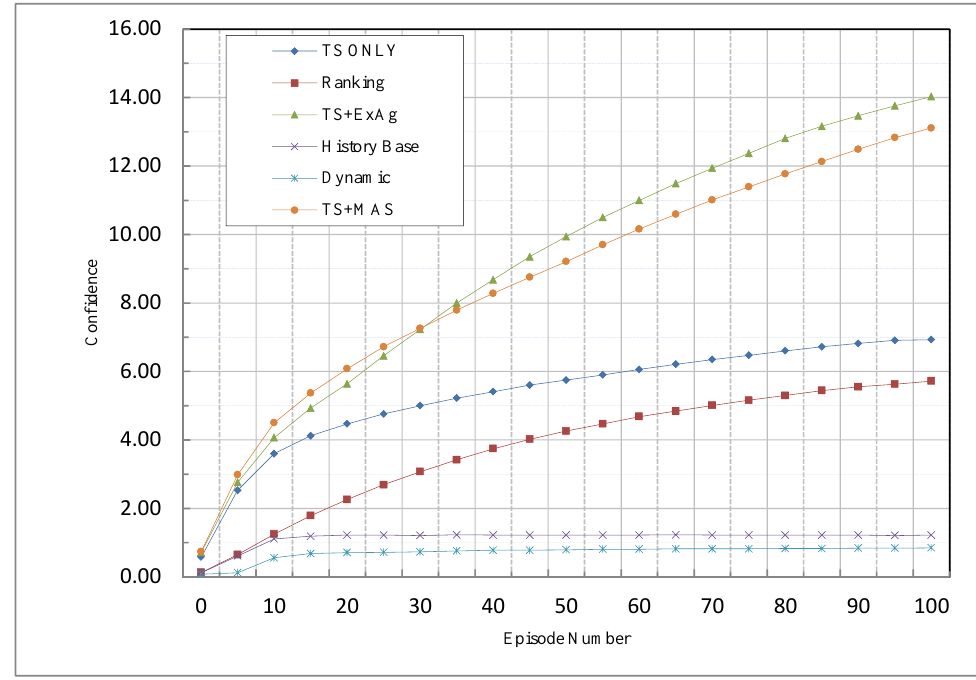
Figure 4. Comparison of MCA methods based on the confidence